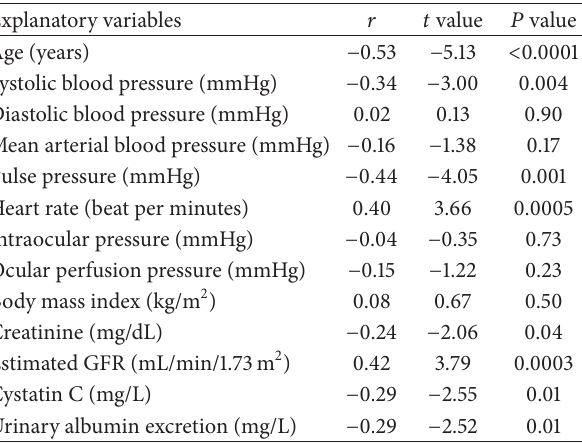
Table 4: Results of Pearson’s correlation analysis between blowout time and all